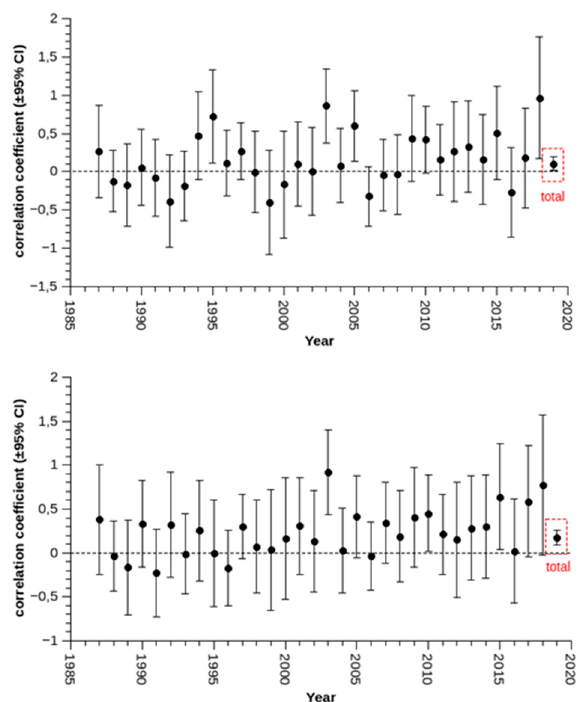
Figure 4. Top: E ff ect estimates of same day NO 2 on residuals of GAM. Bottom: E ff ect estimates of Figure 4. Top: Effect estimates of same day NO 2 on residuals of GAM. Bottom: Effect estimates of previous day NO 2 on residuals of GAM. previous day NO 2 on residuals of GAM.